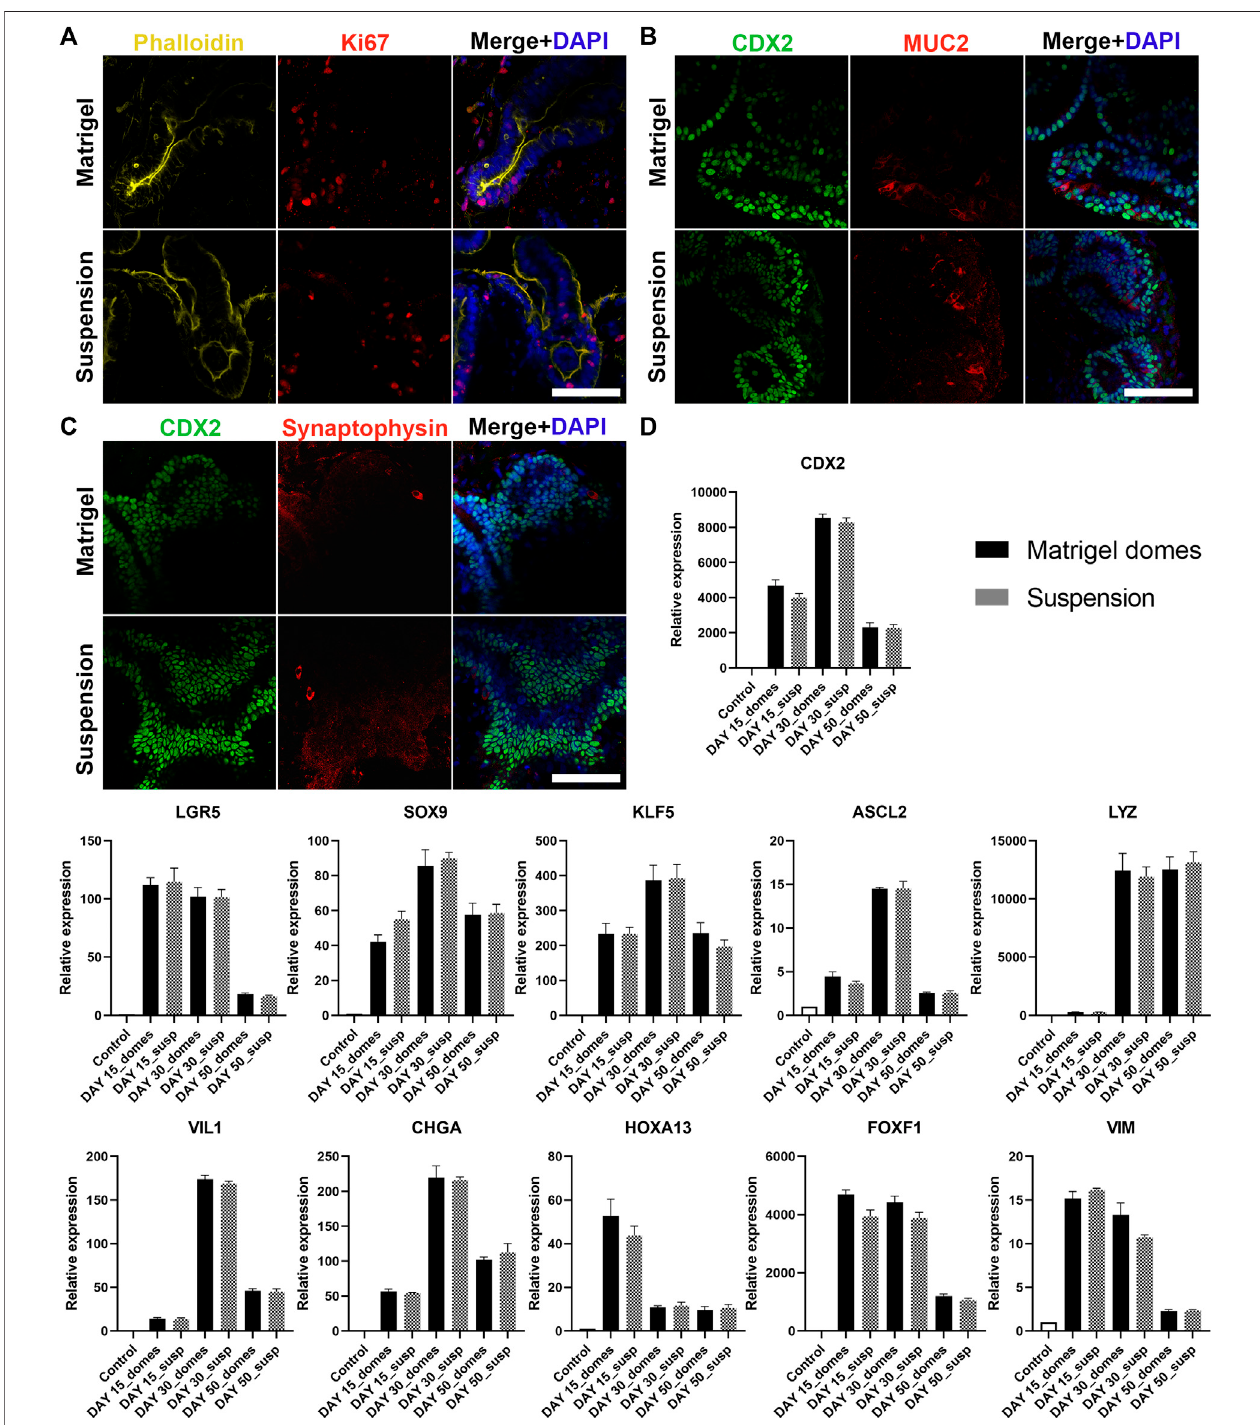
FIGURE 4 | Characterization of H9-derived human intestinal organoids after 30 days in culture. (A – C) Immuno fl uorescence stainings of intestinal markers (Ki67: proliferative cells; CDX2: intestinal transcription factor; MUC2: goblet cells; Synaptophysin: enteroendocrine cells) show similar expression patterns in both embedded andsuspensionorganoids.Scalebars:100 μ m. (D) qRT-PCRanalysisdemonstratestheexpressionlevelsofproliferationgenes( LGR5 , SOX9 , KLF5 , ASCL2 ),intestinal differentiation genes( CDX2 , LYZ , VIL1 , CHGA , HOXA13 ) and mesenchymal genes( FOXF1 , VIM ) after 15, 30and 50 days in culture. Untreated H9cells were used as controls. Statistical analysis showed no signi fi cant difference between the organoids grown embedded in Matrigel and the organoids grown in suspension at any of the time-points. Error bars indicate mean ± S.E.M. ( n = 3).